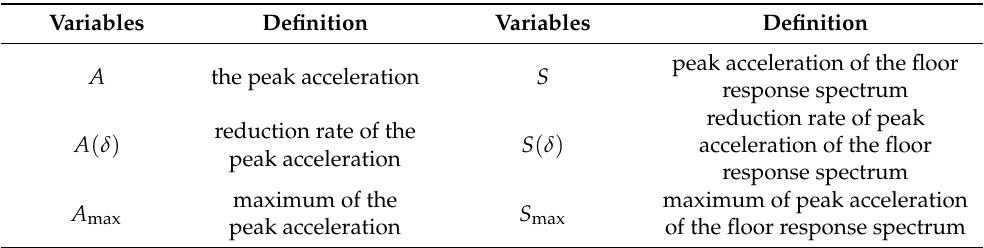
Table 6. The variables nomenclature